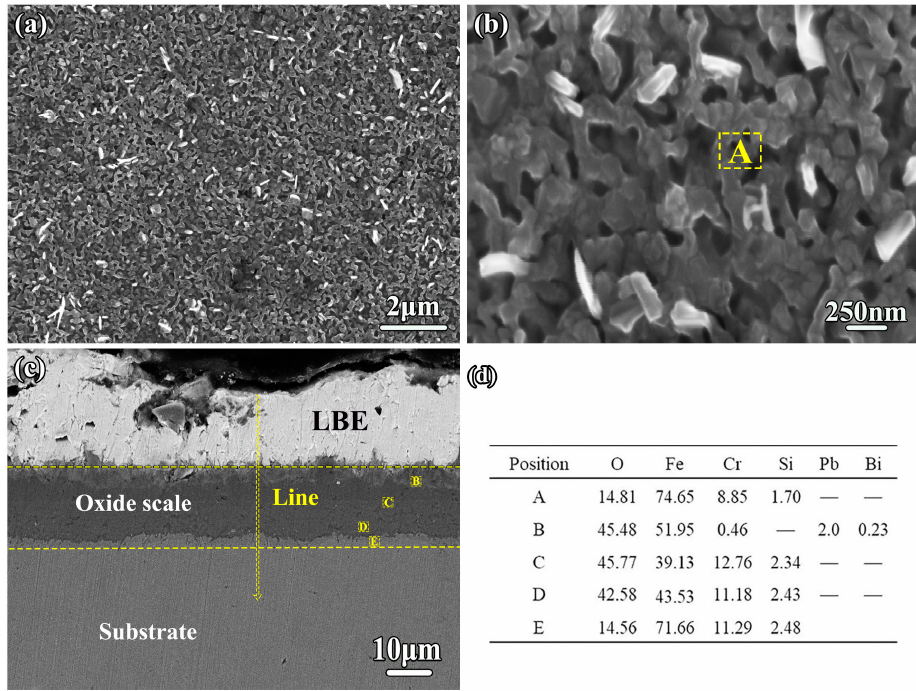
Figure 6. ( a , b ) SEM surface and ( c ) cross sectional images of the T91 steel substrate at 550 °C for 500 h; ( d ) EDS analysis of the microzone shown in ( b , c ).